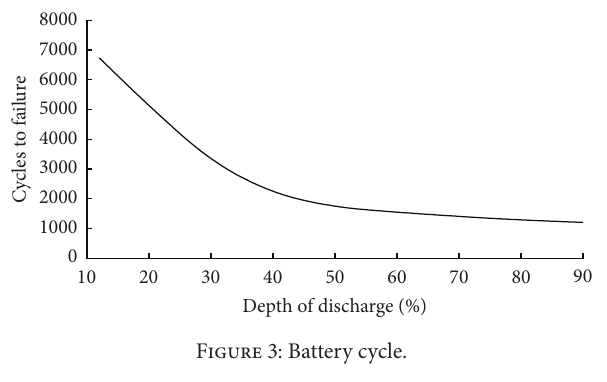
Figure 3: Battery